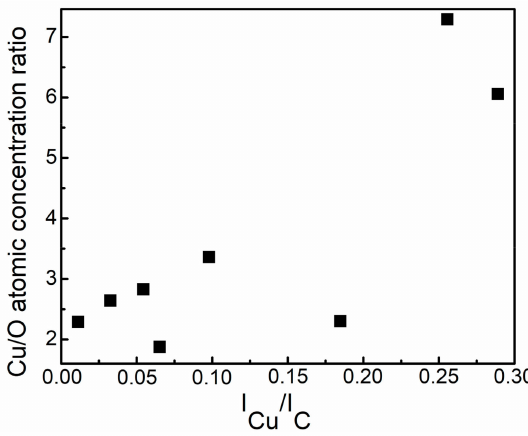
Figure 2. Copper and oxygen (Cu / O) atomic concentration ratio Vs copper and carbon target current ratio (I Cu / I C ). Atomic concentrations measured after the In situ ion beam etching were analysed. Analyzing C1s, O1s, Cu2p, and Cu LMM XPS peaks was undertaken to investigate chemical bonds on the surface of the ion beam cleaned samples. The typical spectra are presented in Figure 3. C-C, C = C, C-O, and O-C = O bonds [15] were revealed by analysis of C1s peak (Figure 3a). Cu 2 O fitting component is present in O1s peak [16,17], while the CuO fitting component is rather weak. Only Cu and Cu 2 O peaks [16,18] were found in the Cu2p and Cu LMM spectra. No CuO peak was observed. Thus, one can suppose that copper nanoparticles that are embedded into the DLC matrix consist of copper and Cu 2 O.